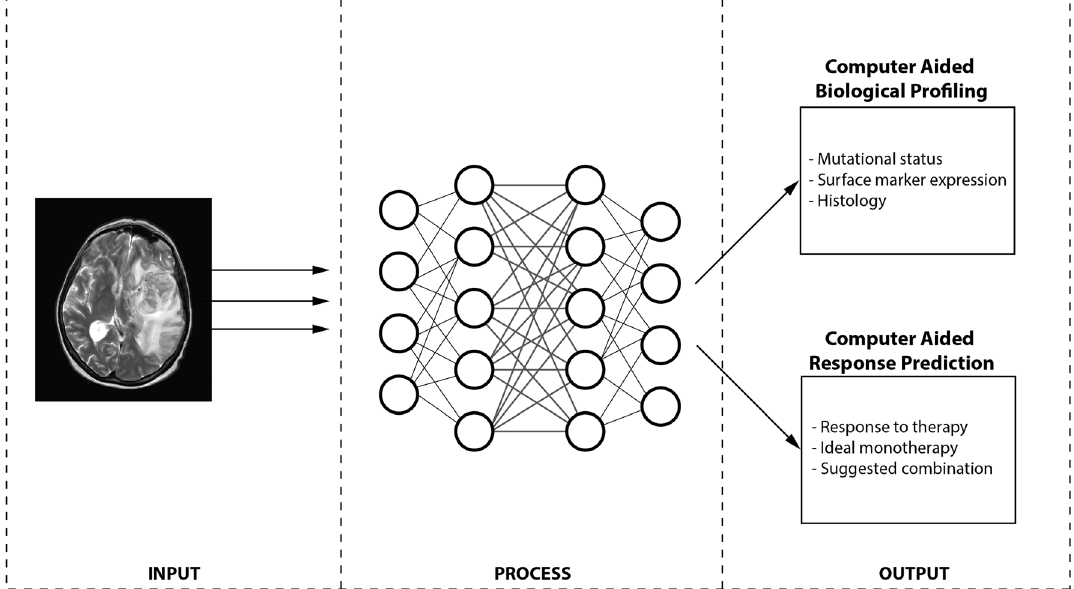
Fig. 1 A schematic of a future radiomics pipeline highlighting a simplified workflow for CABP and CARP wherein patient images are input into a specialized (series of) AI algorithm(s) and, based on the outcome, can be classified. CABP algorithms assess the profile of the